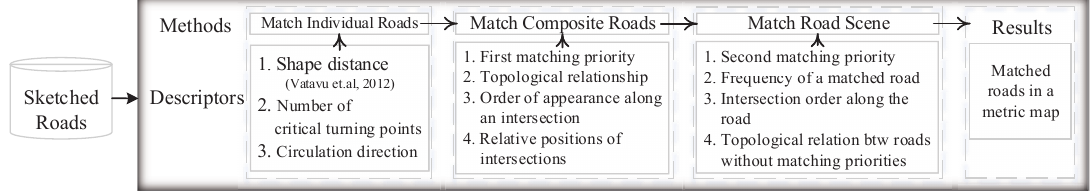
Figure 2. Framework for sketched road